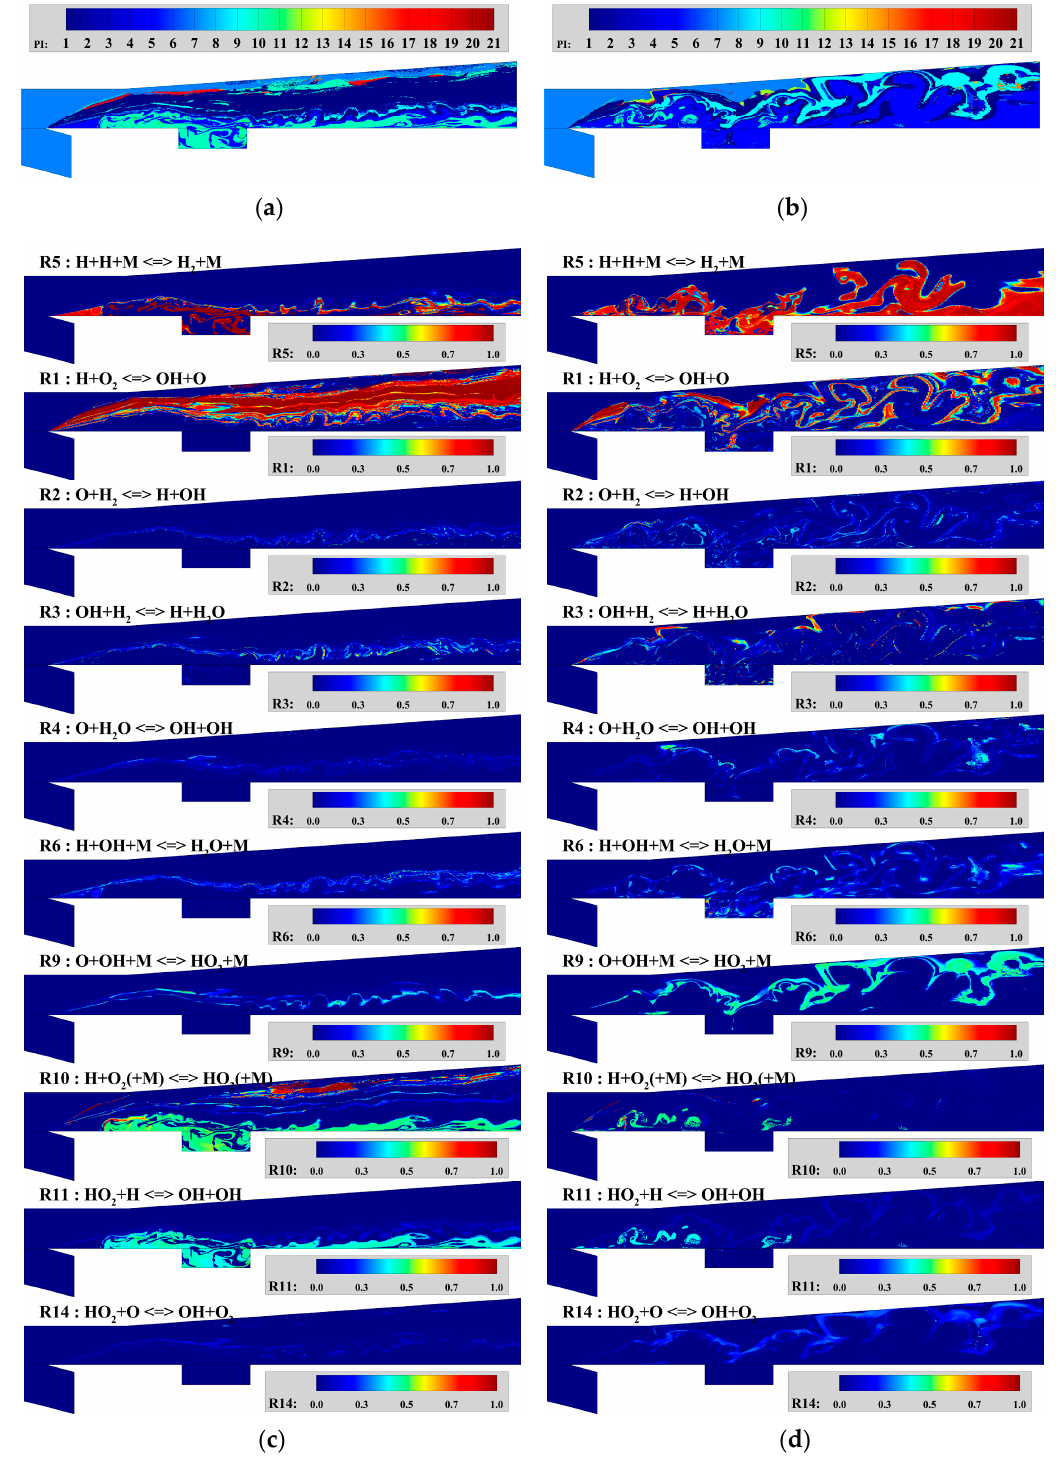
Figure 10. Results of the chemical mode explosive analysis for each injection pressure case: dominant PI results for ( a ) 0.75 MPa and ( b ) 1.0 MPa; normalized PI results for ( c ) 0.75 MPa and ( d ) 1.0 MPa.